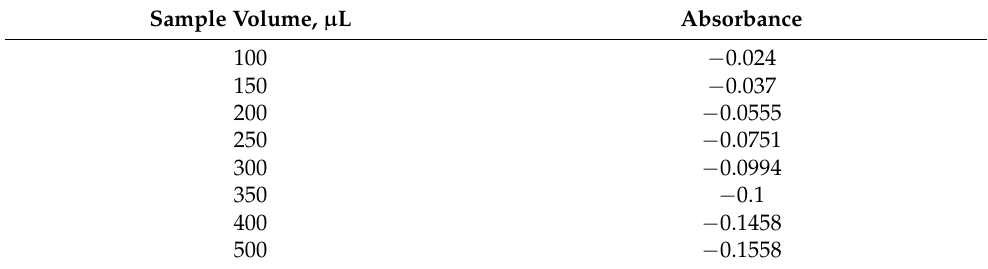
Table 1. Variation of absorbance of Cu-PCV with the volume of 30 µ g mL − 1 CTAB solution.